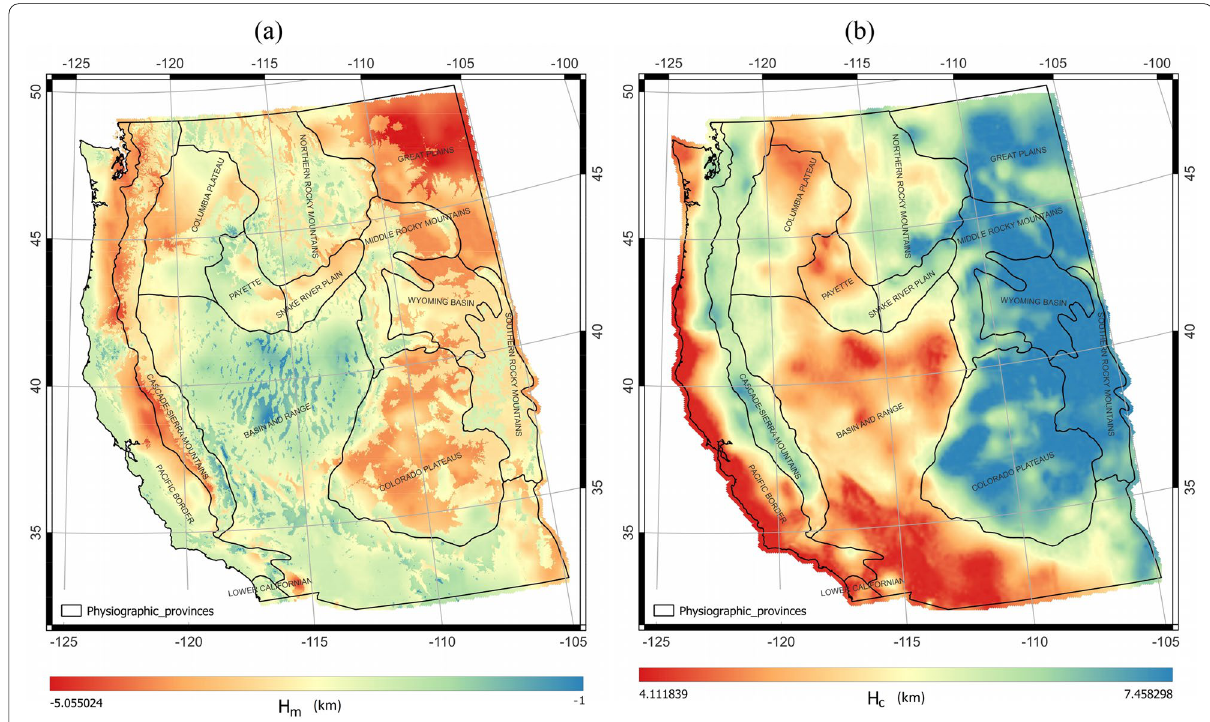
Fig. 10 a Estimated mantle topography, b calculated crust topography in the study area